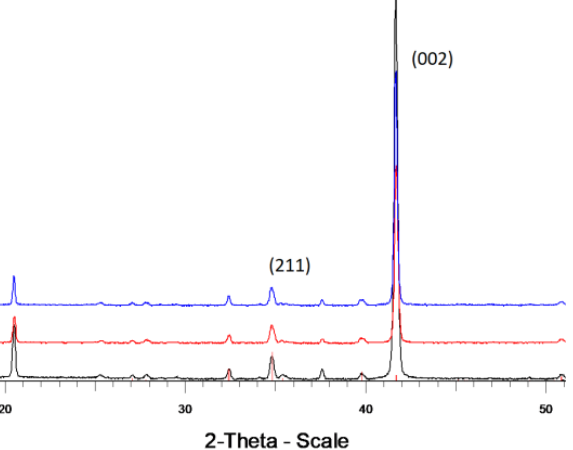
Figure 13. XRD patterns of samples of parent glass C3 heat treated at 850 °C for 5 h (black pattern), 900 °C for 1 h (red pattern) and 950 °C for 0.5 h (blue pattern).